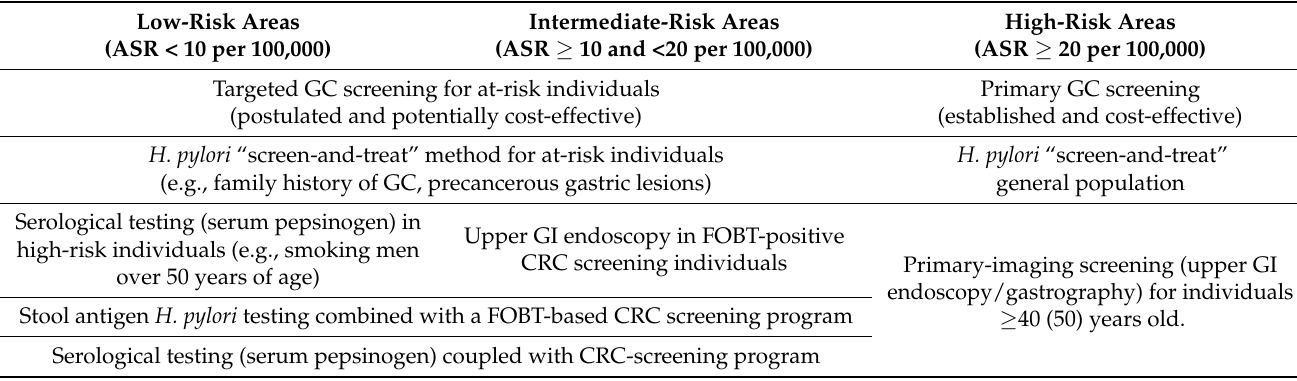
Table 2. Summary of established and postulated screening strategies for gastric cancer in different risk